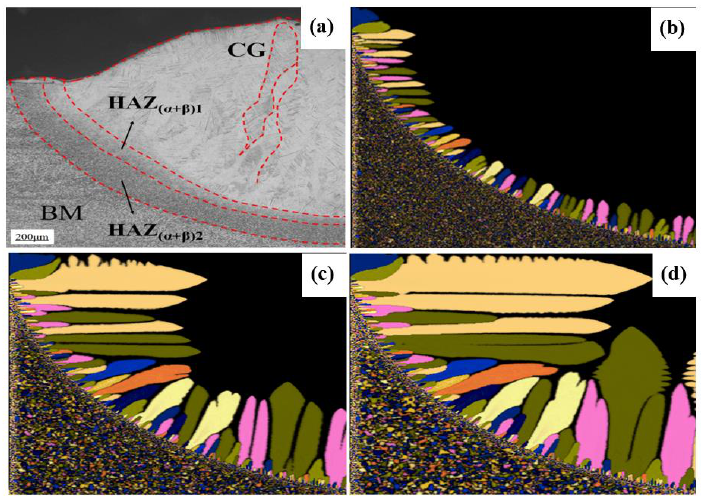
Figure 12. Comparison between the cross section of the single-channel machining experiment and the simulated dendrite morphology.( a ) Wire Laser single-channel microstructure, ( b ) t=0.0018s, ( c ) 0.003s, ( d ) 0.0046s.